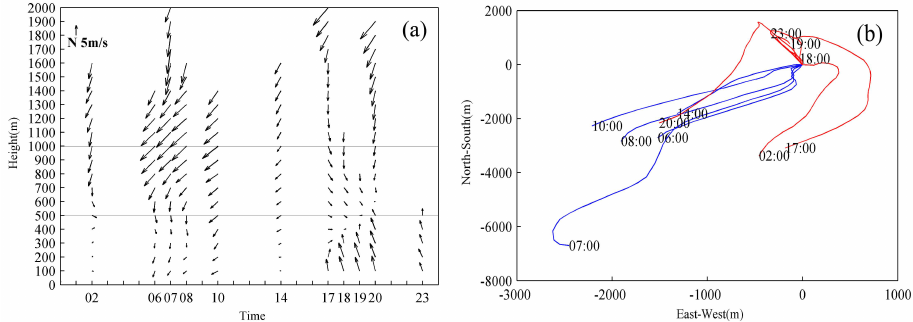
Fig. 5. Vertical wind profiles obtained by radio soundings and balloon trajectories on 16 October 2004 at the Xinken station.